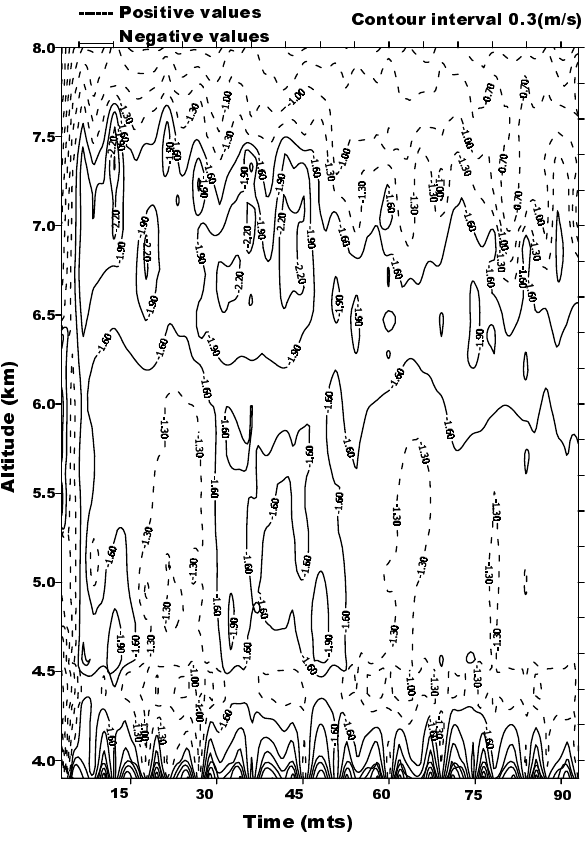
Fig. 5. Evolution of downdraft during the convection event on 28 August 1999: 13:00 to 14:30LT. Full lines indicate downdraft and dashed lines indicate updraft and the contour interval is 0.3ms − 1